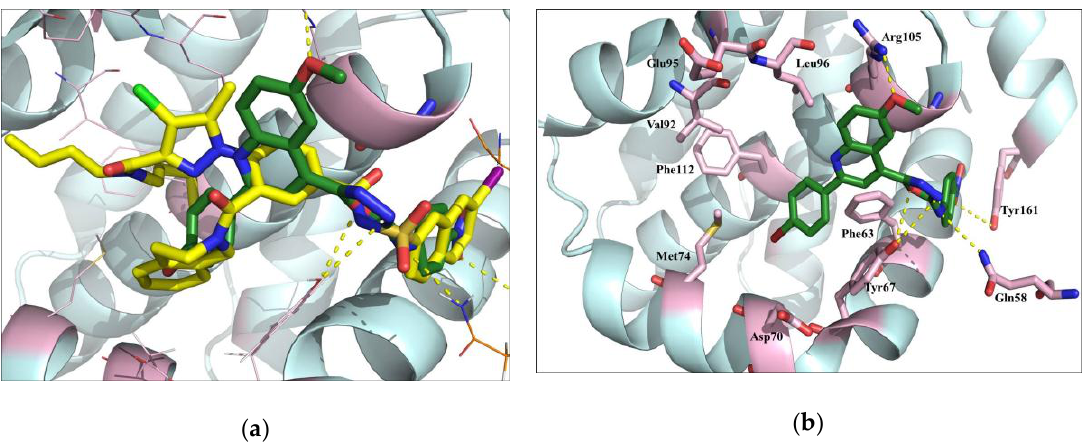
Figure 2. ( a ) Representation of the binding mode of compound 6i (green stick) and native iodonaphthalene sulfonamide-based ligand (yellow stick) from the co-crystal structure with Bcl-2 (PDB code 4AQ3), showing the overlap in binding poses between the two ligands. ( b ) representative interactions of compound 6i (dark green stick) with key residues (purple stick) of the Bcl-2 binding pocket. H-bonds represented as yellow dotted